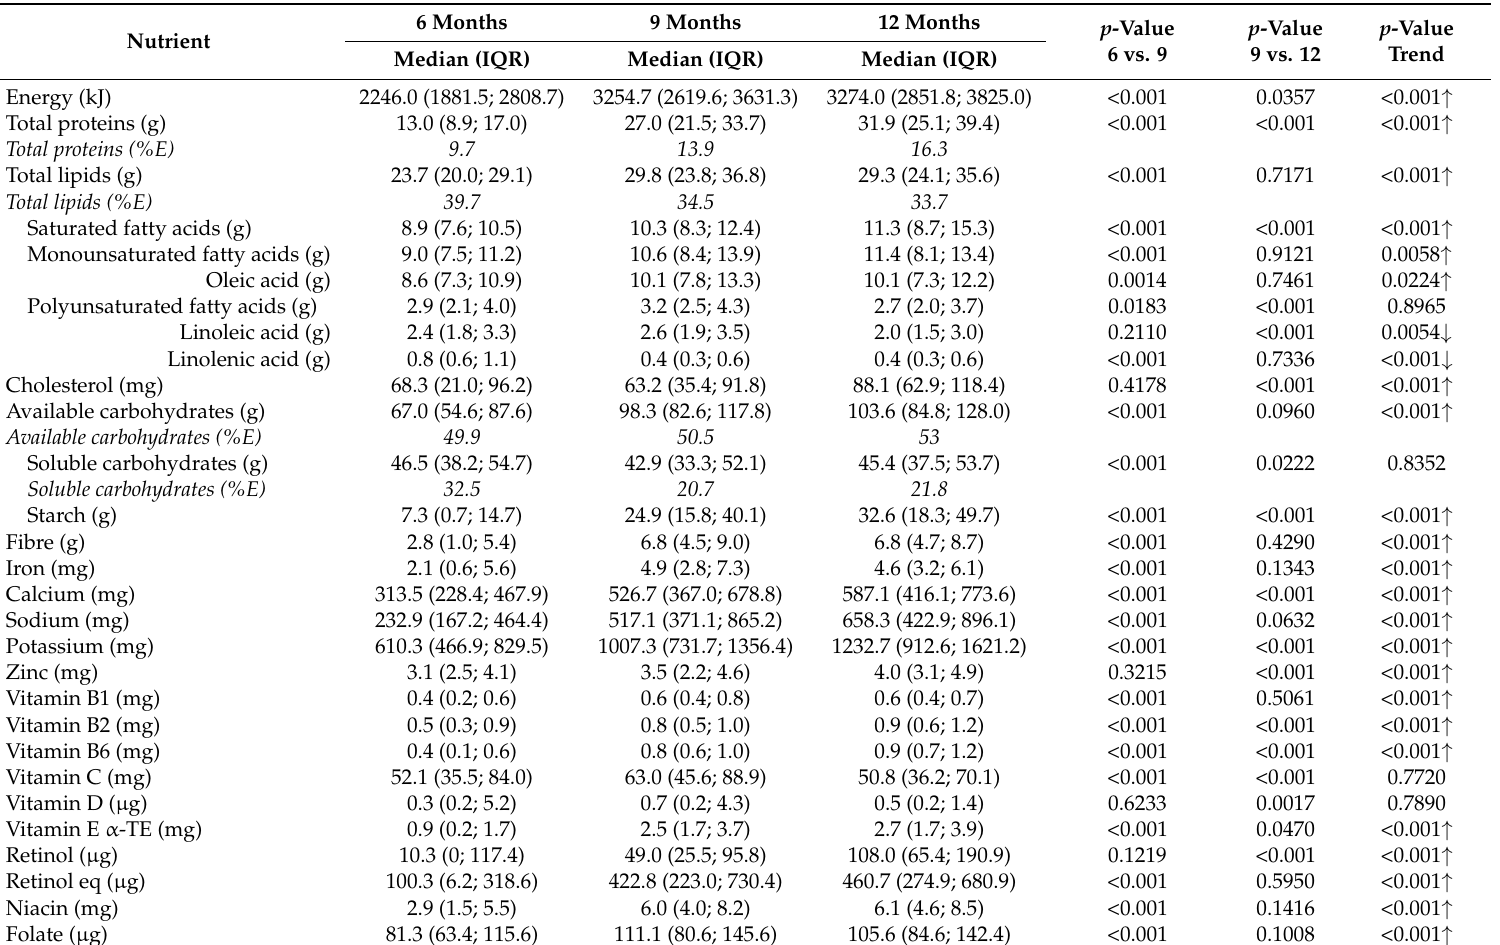
Table 2. Daily energy, macronutrient and micronutrients intake from 6- to 12 months of age ( n =